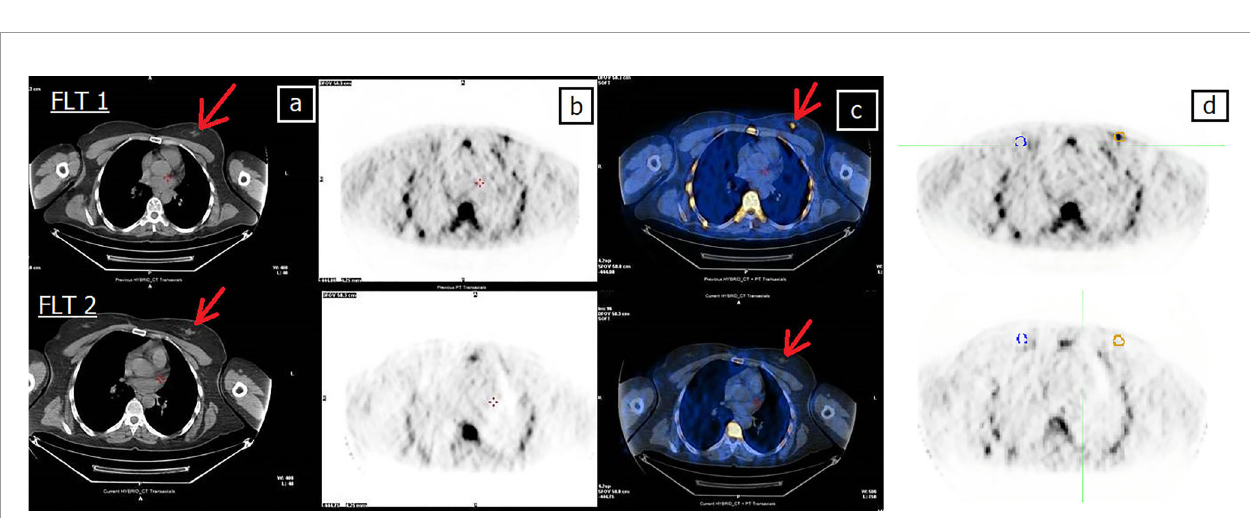
FIGURE 3 | Forty-four-year-old patient (patient 11 in Table 2 ) undergoing NCT for locally advanced right BC. (A) CT, (B) FLT-PET, (C) CT and FLT-PET fusion, and (D) delineation of lesion (yellow line) and controlateral breast (blue line). Upper row: FLT 1; lesion SUV max = 2.7. Bottom row: FLT 2; FLT 2 shows the complete disappearance of uptake in the tumor area, still evident at CT (arrow). Red arrow indicates breast lesion. Post mastectomy histological examination revealed the absence of neoplastic tissue. EORTC PET classi fi cation: CR (complete